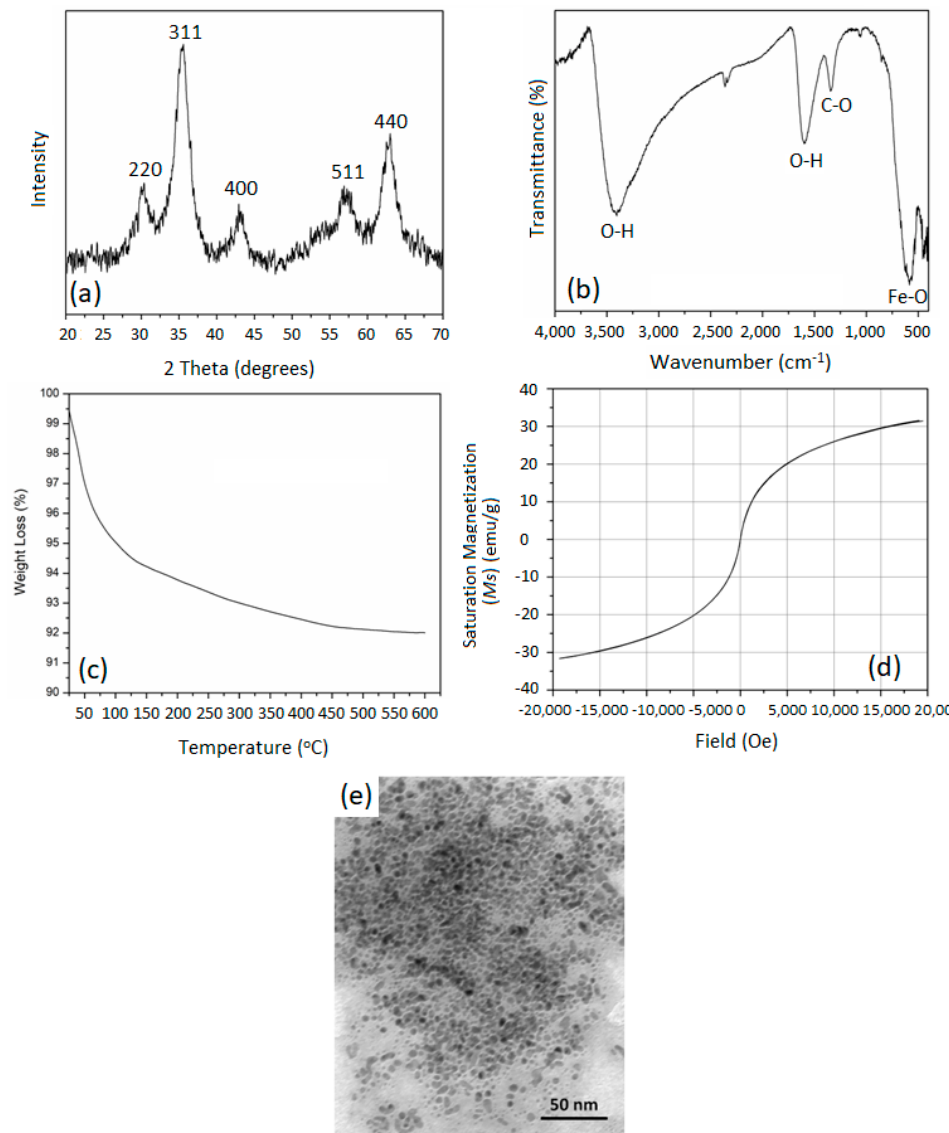
Figure 1. ( a ) XRD pa tt ern, ( b ) FT-IR spectrum, ( c ) TGA thermogram, ( d ) magnetization